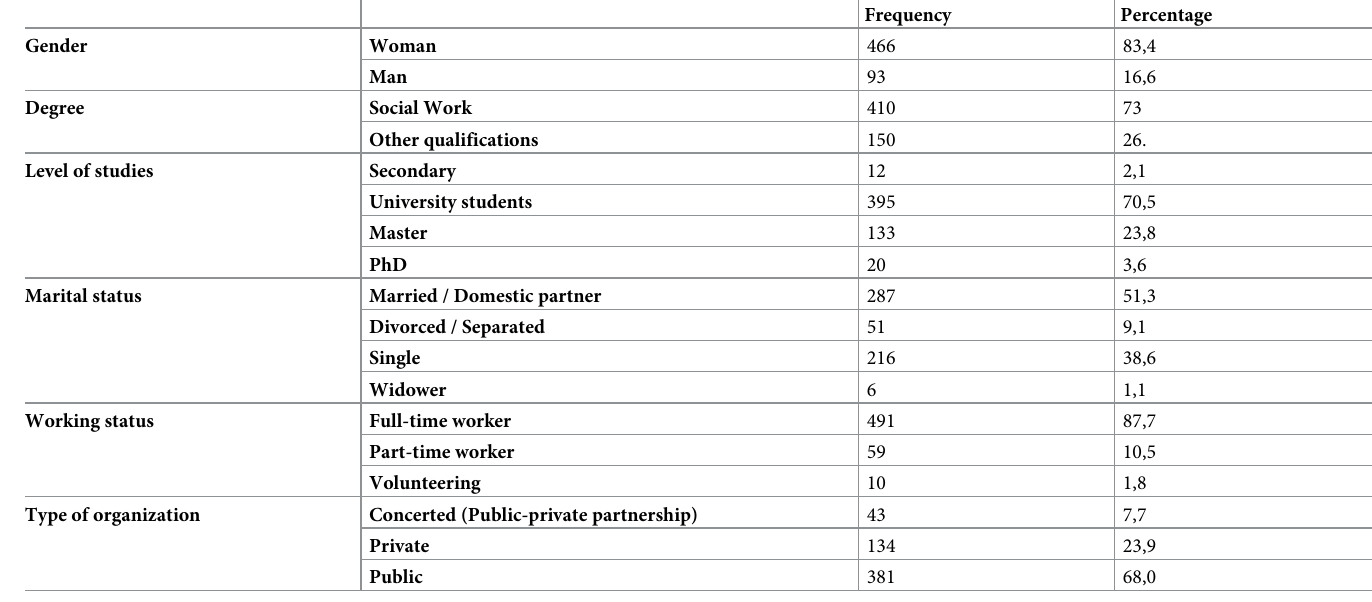
Table 1. Socio-demographic